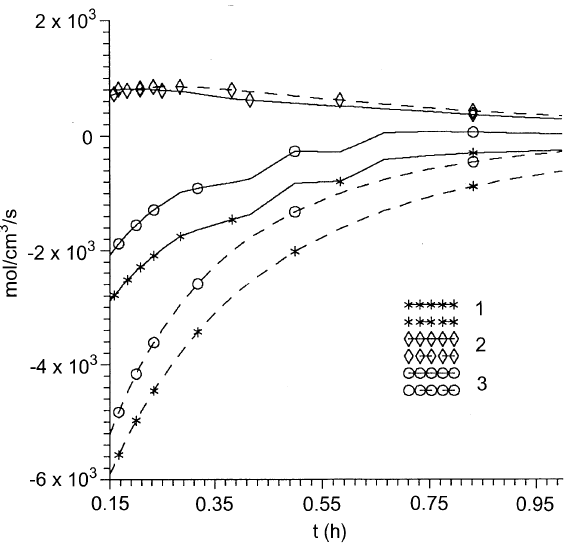
Fig. 6. Same as in Fig. 4 but for HNO (cid:51)